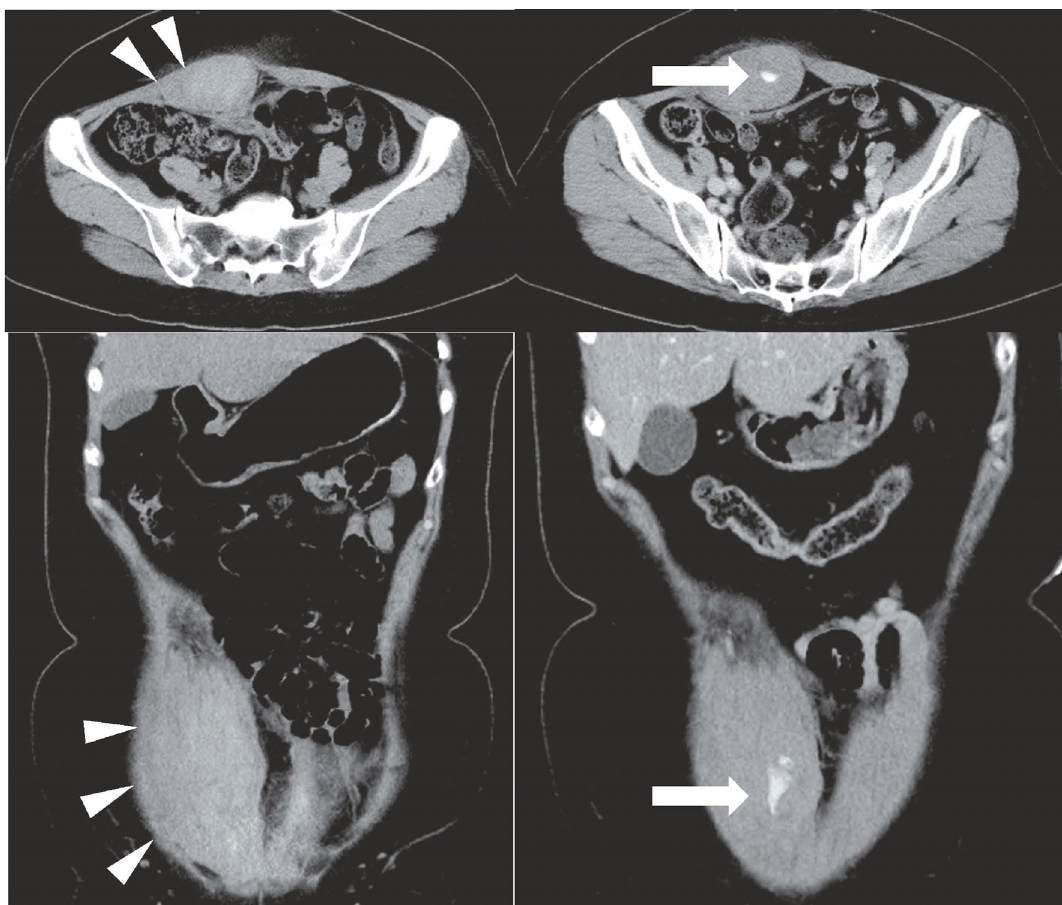
Figure 1: Abdominal and pelvic computed tomography demonstrated bilateral rectus sheath hematoma (white arrowhead). The hematoma extended into the median umbilical fold, forming a large mass that spread to the suprapubic area.